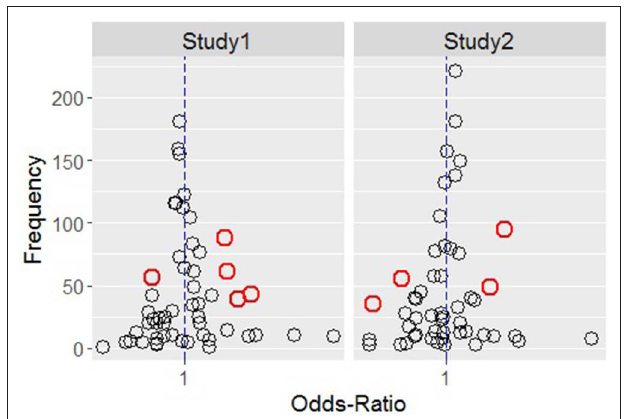
FIGURE 4 | Transitions distribution by odds-ratio (x-axis) and absolute frequency (y-axis) for study 1 (Left) and study 2 (Right) conditions.